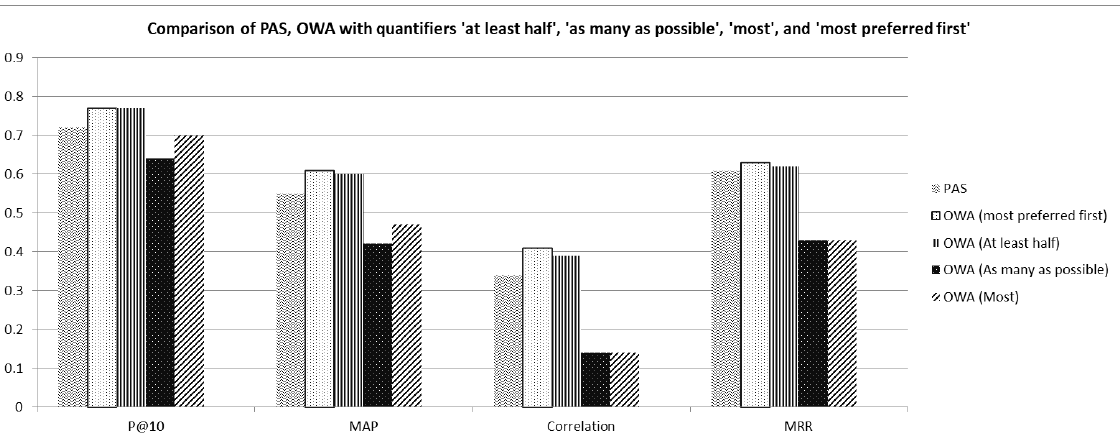
Figure 5. Comparison of related recommendation approaches for veracity measures including P@10, MAP, MRR, and modified Spearman’s rank correlation coefficient.